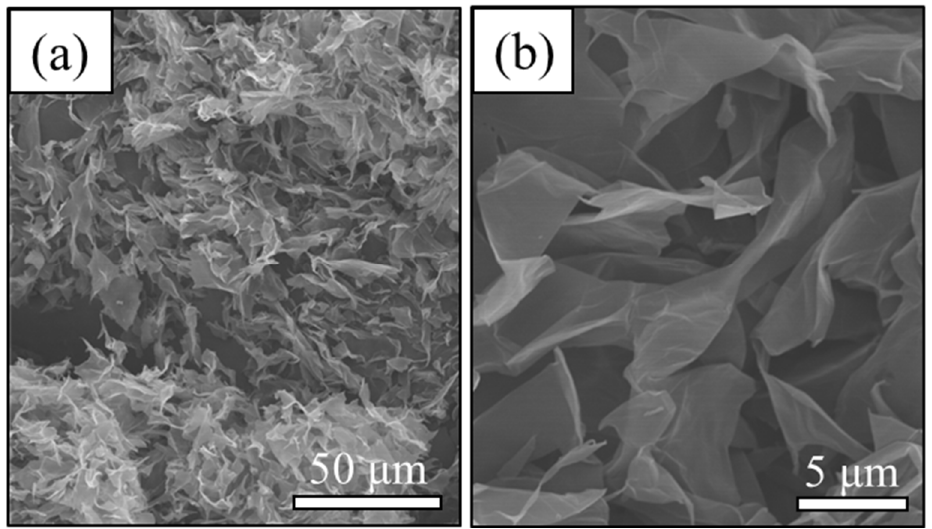
Figure 1. HRSEM images of pure GO microsheets.